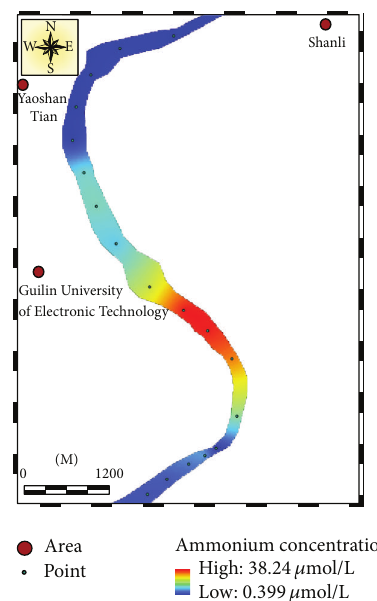
Figure 6: The spatial variation of ammonium concentration in Huajian